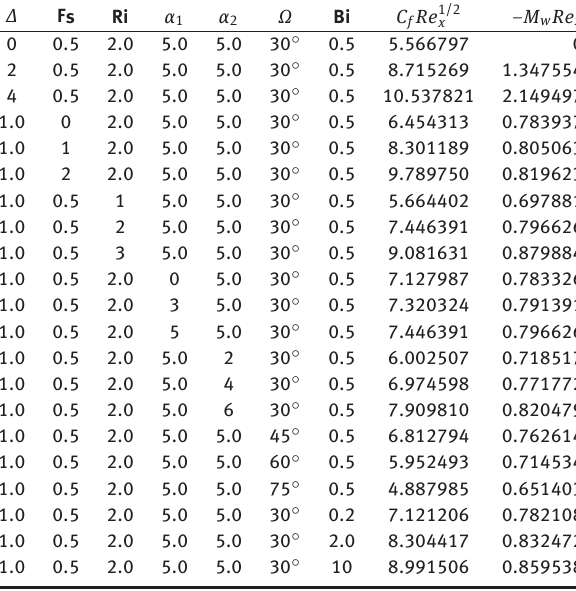
Table 2: Effect of skin friction and wall couple stress for various values of Δ , Fs , Ri , α 1 , α 2 , Ω , Bi